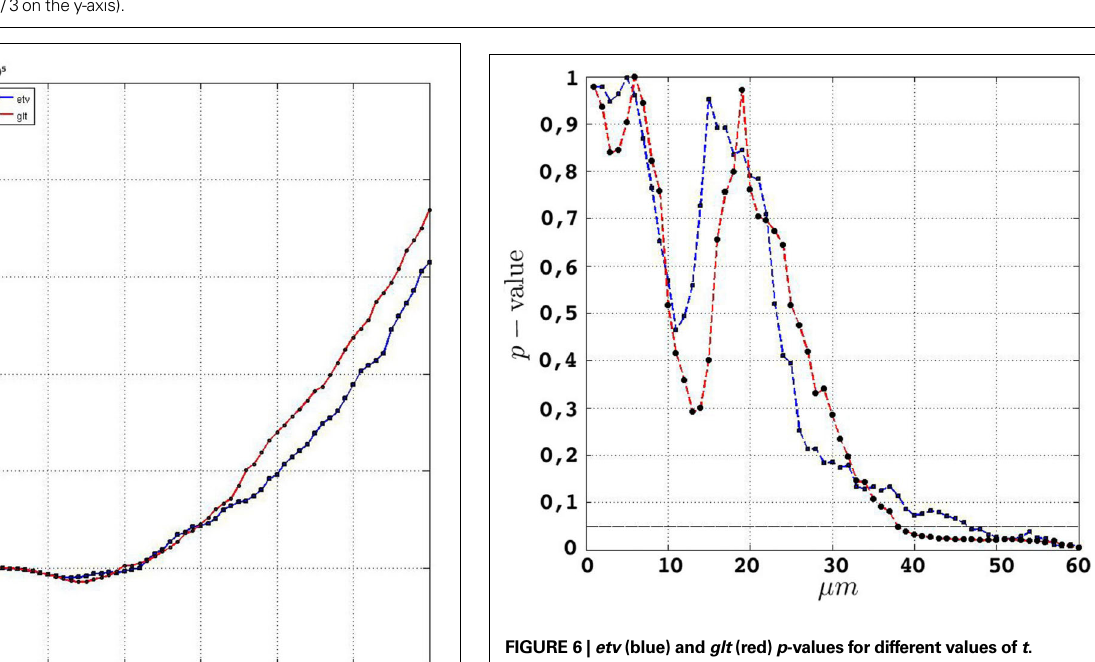
FIGURE 4 | 500 estimations of the K -function based on simulations under CSR for samples identical in geometry to etv-pyramids (A,C) and glt-pyramids (B,D). The simulations demonstrate the expected outcome when estimating the K-function without (A,B) and with (C,D) the edge correction term under CSR (having K t